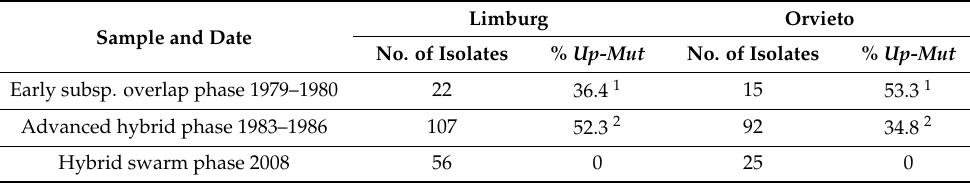
Table 3. Change in frequency of the up-mut colony dimorphism at the Limburg and Orvieto sites. Sample and